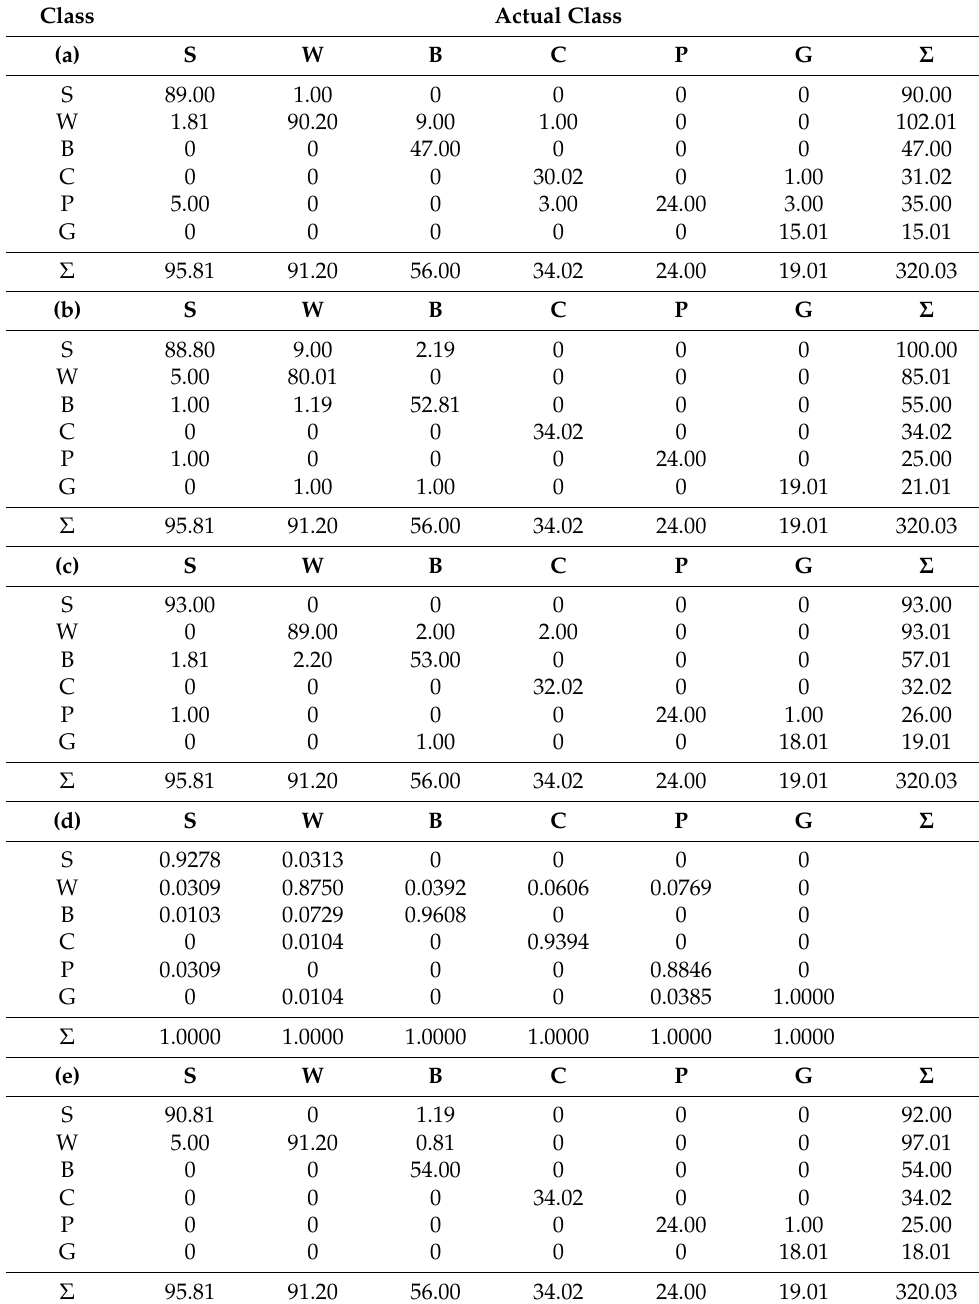
Table 4. Confusion matrices predicted from the outputs from the latent class analysis. ( a ) for the discriminant analysis, ( b ) for the decision tree, ( c ) for the neural network and ( d ) for the support vector